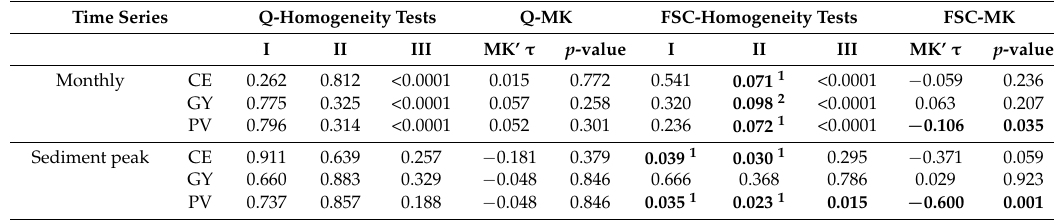
Table 2. Homogeneity and trend test for the monthly and sediment peak (DJFM) time series 2003–2017. p- values for the Pettit test (I), Buishand (II), and von Neumann (III) homogeneity tests. Kendall’s τ for Mann–Kendall (MK) trend test and its associated p- value. Black highlight values denote significance at the 90 and 95% CIs.